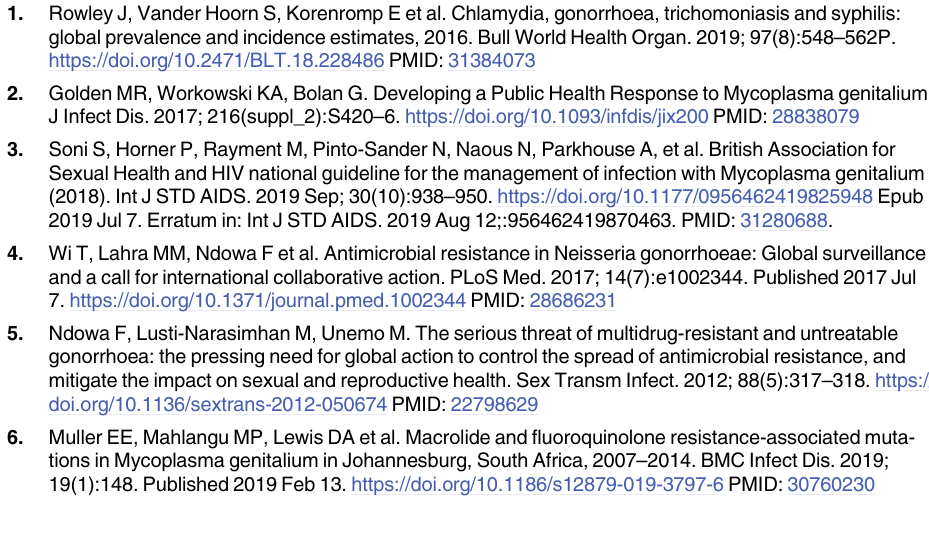
S1 Table. Classified species read counts and percentage of whole sequencing library and individual samples. S2 Table. Mean log(10) read counts in clinical swab samples analysed by single gene tar- geted PCR nanopore sequencing by